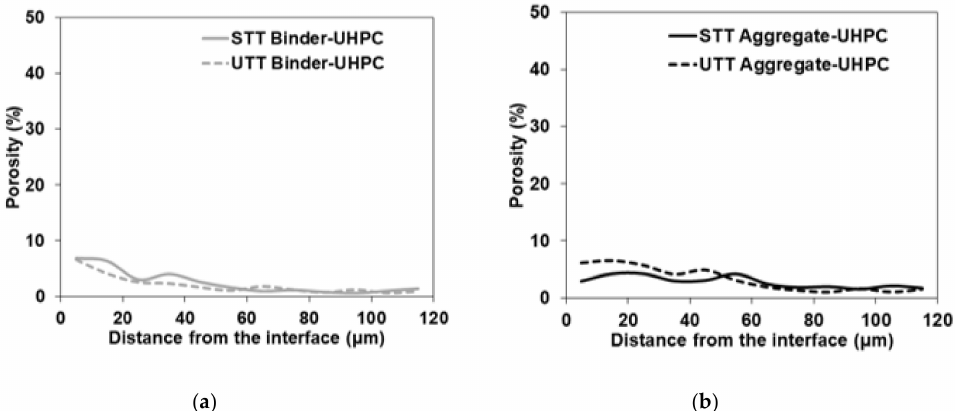
Figure15. Fractionofporosityawayfrombinder-UHPCandaggregate-UHPCinterfacefor( a )shuttering plywood (STT); ( b ) untreated plywood (UTT) formwork.